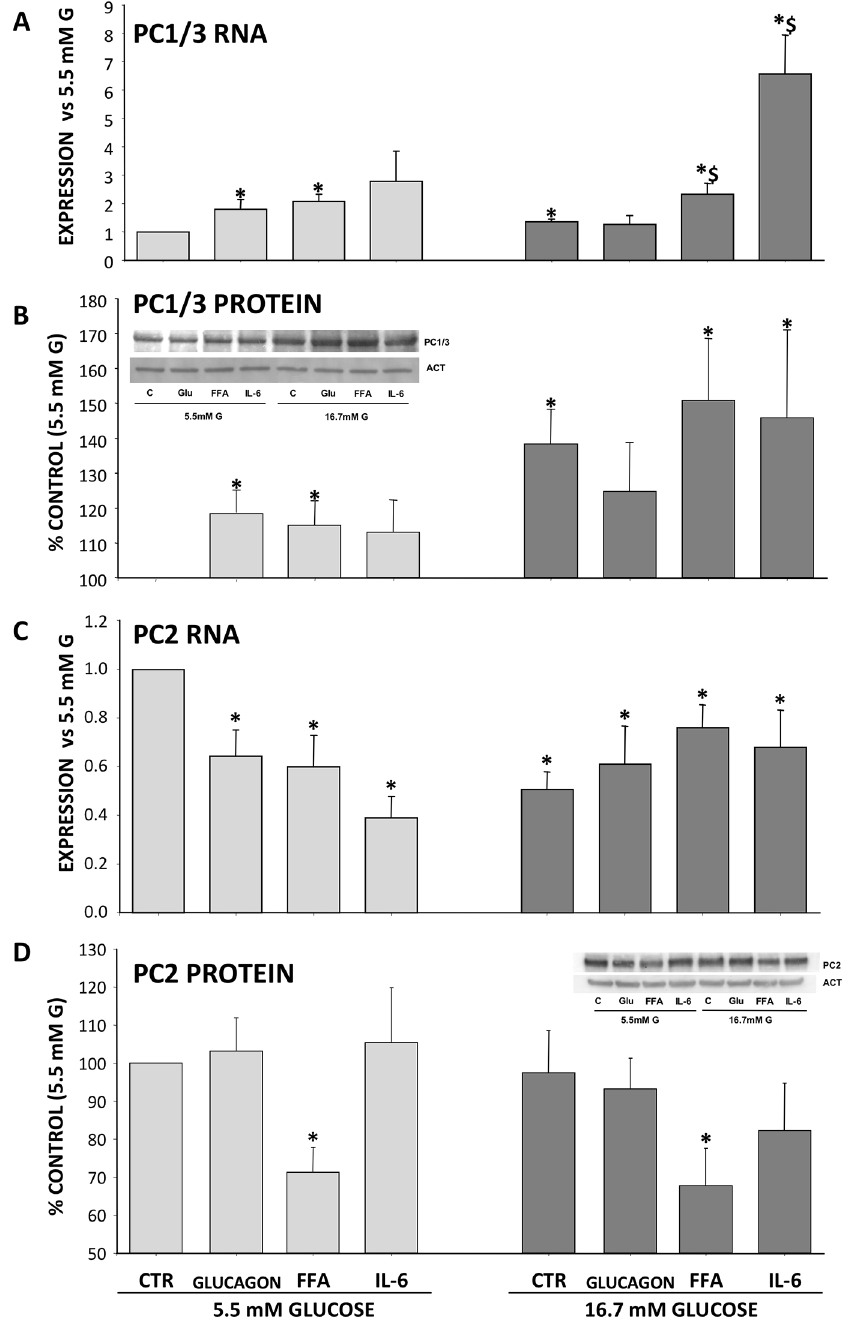
Fig 4. Effect of metabolic/hormonal pertubation on PC1/3 and PC2 expression. Cells were incubatedfor 16 h in the presenceof 5.5mM or 16.7mM, in the additionalpresenceof glucagon,FFA and IL-6, total mRNA and protein were extracted and PC1/3 and PC2 expressionwere determinedby Real Time PCR using specific primers and SDS-PAGE and Western Blotting. Panel A: PC1/3 RNA, Panel B: PC1/3 protein, Panel C: PC2 RNA and Panel D: PC2 protein. Results are Times vs control (5.5mM glucose)and % of control (5.5mM glucose)and expressedas MEAN ± SEM, n = 5–7. * p < 0.05comparedto control; $p < 0.05compare to control (16.7mM